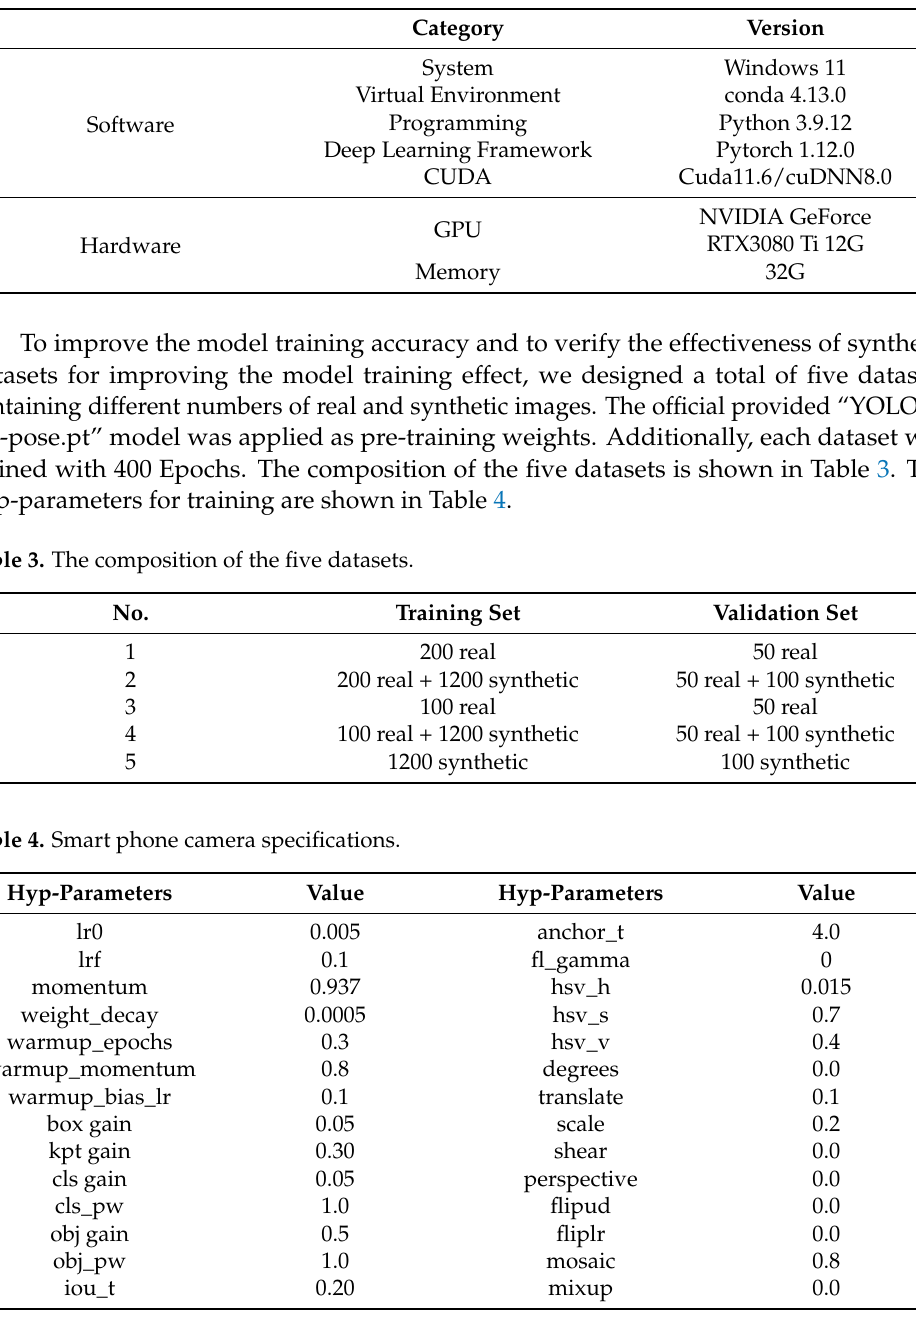
Table 2. The workstation configurations.